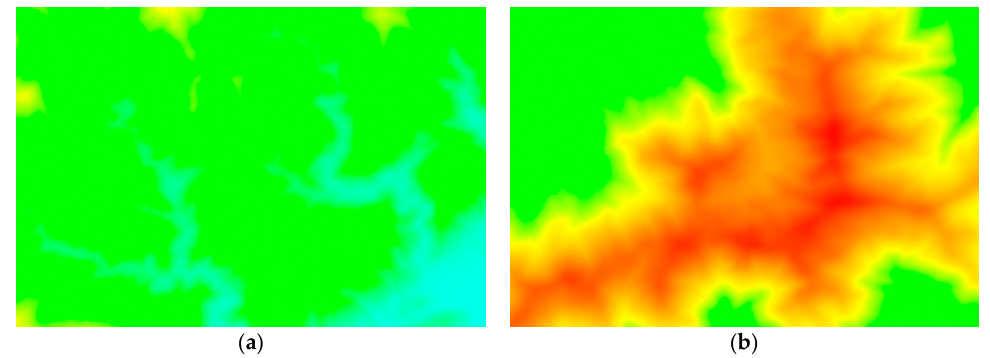
Figure 16. Images display the terrain of the experimental areas. ( a ) A relatively flat region with some low elevation hills; and ( b ) a mountainous region. low elevation hills; and ( b ) a mountainous region.